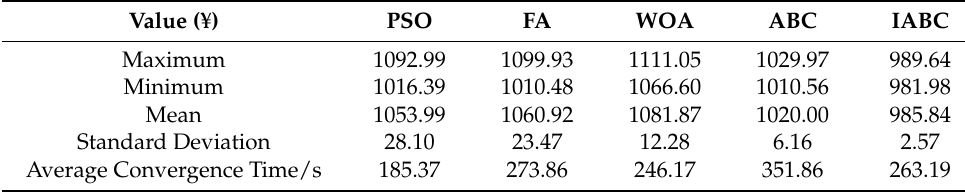
Table 7. Cost comparison of different algorithms.